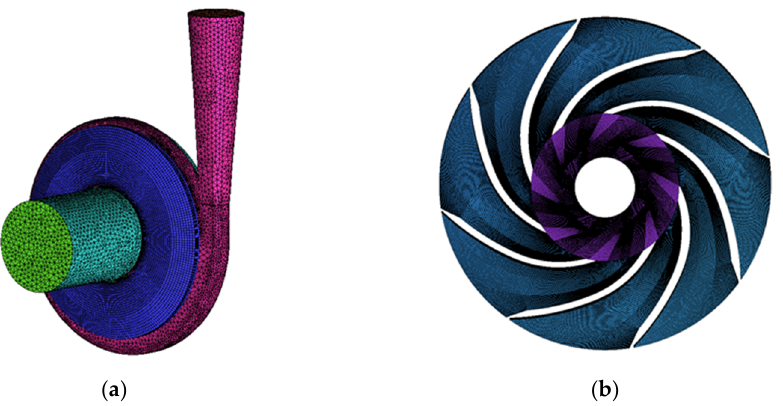
Figure 1. Computational domain of the centrifugal pump.